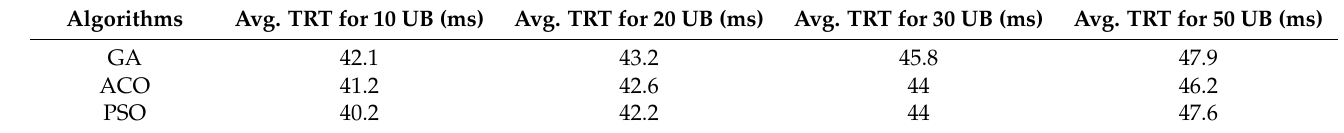
Table 9. Performance analysis of avg. TRT for 10, 20, 30, and 50 UB with 15 DC.